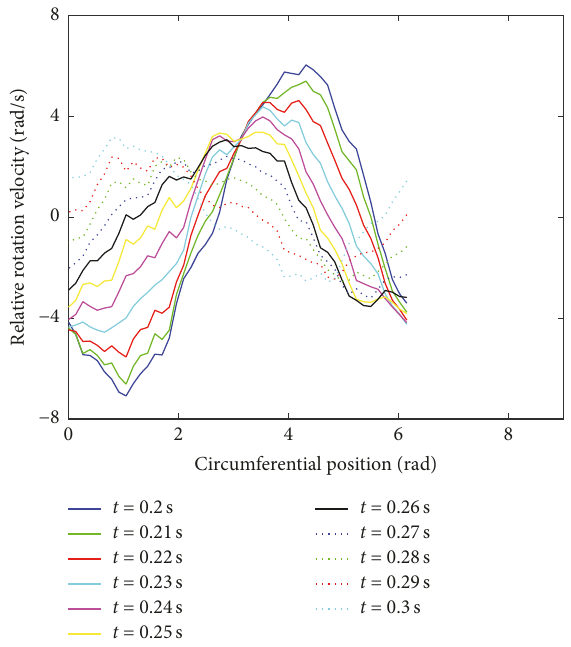
Figure 21: The relative rotation velocity of each node at different